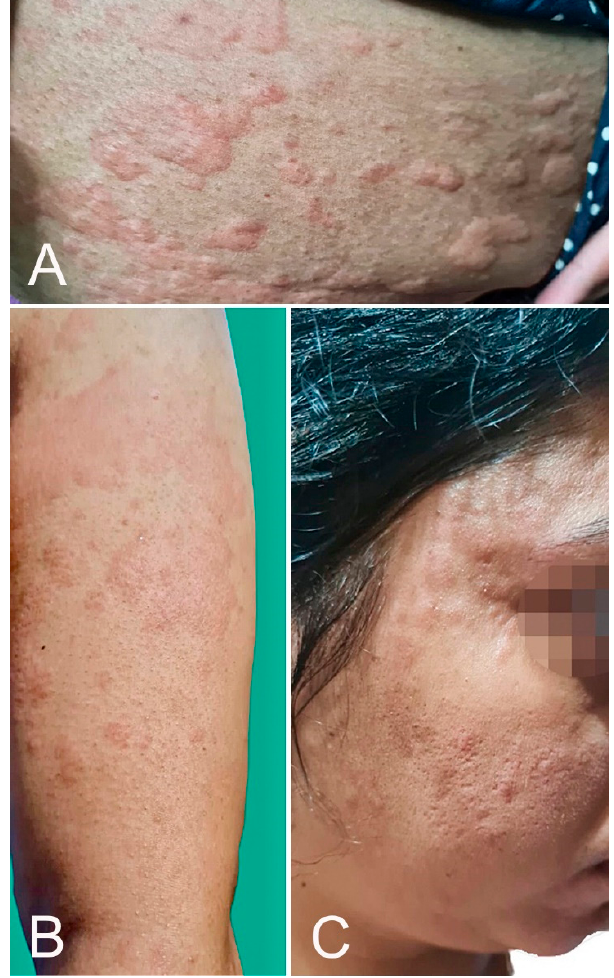
Figure 2. Urticarial eruption: wheals over the upper limb ( A ), trunk ( B ), and face ( C ) developed 2 h after AZD1222 vaccination .